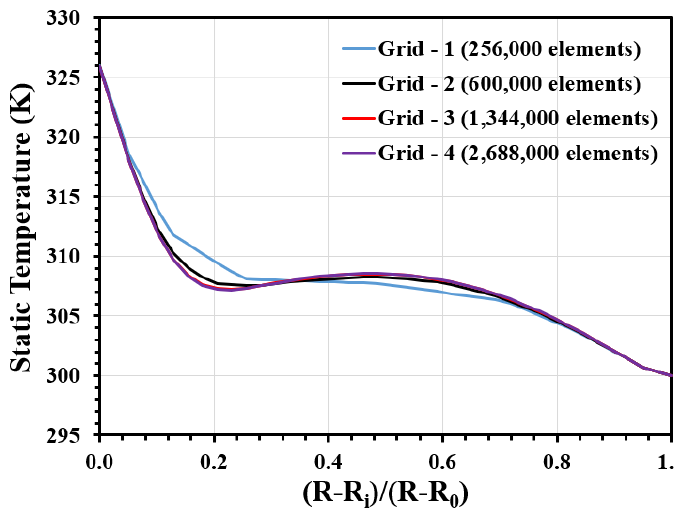
Figure 3. Grid-independence